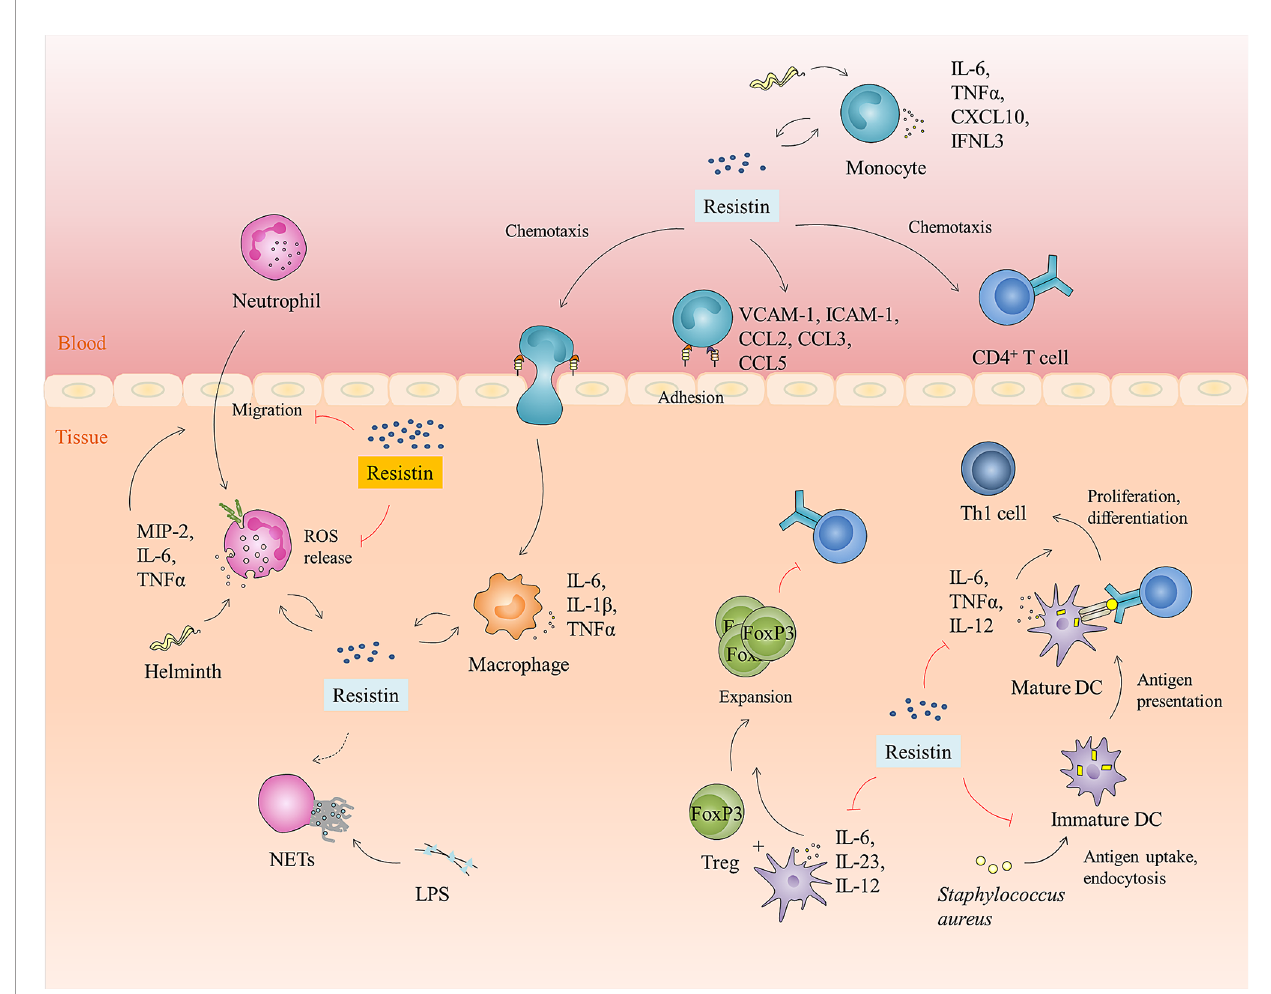
FIGURE 4 | Immunomodulatory function of resistin. Resistin is involved in the host anti-infection immune process by interacting with a variety of immune cell types in humans. It can directly or indirectly promote the adhesion, in fi ltration, and migration of human monocytes, neutrophils, and CD4 + T cells. Likewise, resistin can activate monocytes, macrophages, and neutrophils, promote pro-in fl ammatory cytokines production, and reinforce IFNL3 expression. Moreover, it can also enhance extracellular bacterial killing, namely promote the formation of NETs. However, in certain diseases or contexts, resistin impedes human neutrophils ’ function by inhibiting neutrophils migration and ROS production. It also inhibits antigen uptake, endocytosis, and cytokine production of human DCs, induces expansion of Tregs, and suppresses the proliferation and differentiation of CD4 + T cells into Th1 cells by regulating